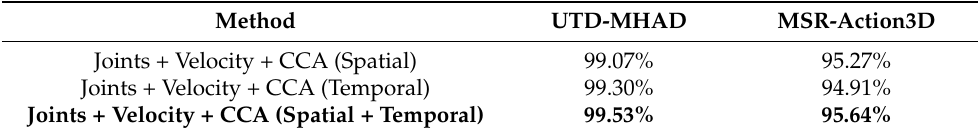
Table 6. Performance of different attention mechanisms of the proposed method on UTD-MHAD and MSR-Action3D dataset.